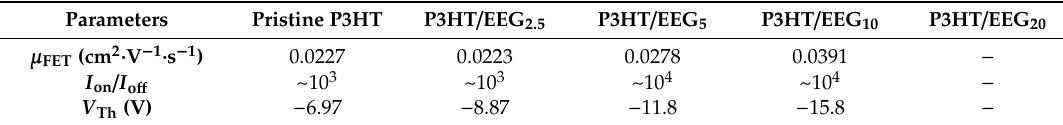
Figure 3. ( a ) Transfer characteristics of OFETs based on pristine P3HT and P3HT/EEG nanocomposite films. ( b ) Output characteristics of OFET based on P3HT/EEG 10 nanocomposite film. Table 1. Device performance parameters of OFETs based on pristine P3HT and P3HT / EEG nanocomposite